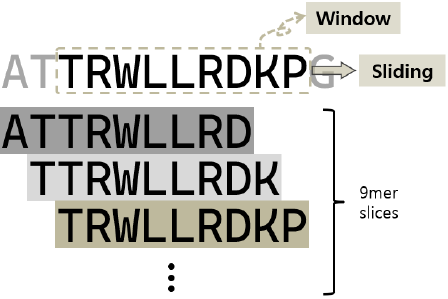
Figure 3. Preparation of 9-mer peptide sequences using the sliding window method for training the AiCPP model.